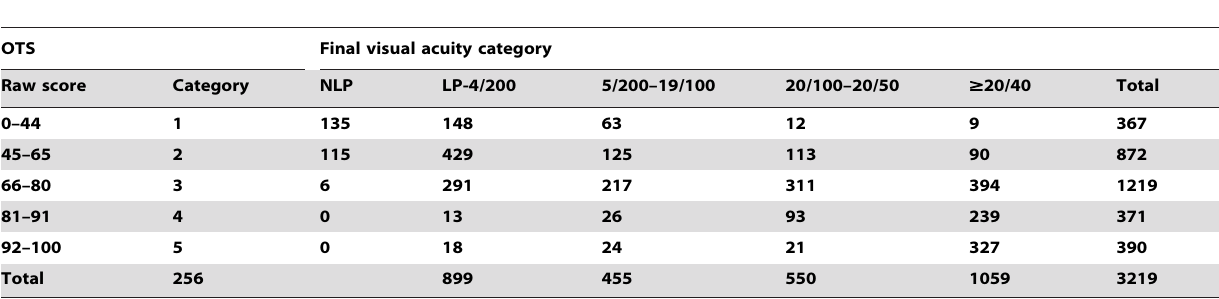
Table 5. Correlation of the final visual acuity category with the Ocular Trauma Score in 3219 eyes.